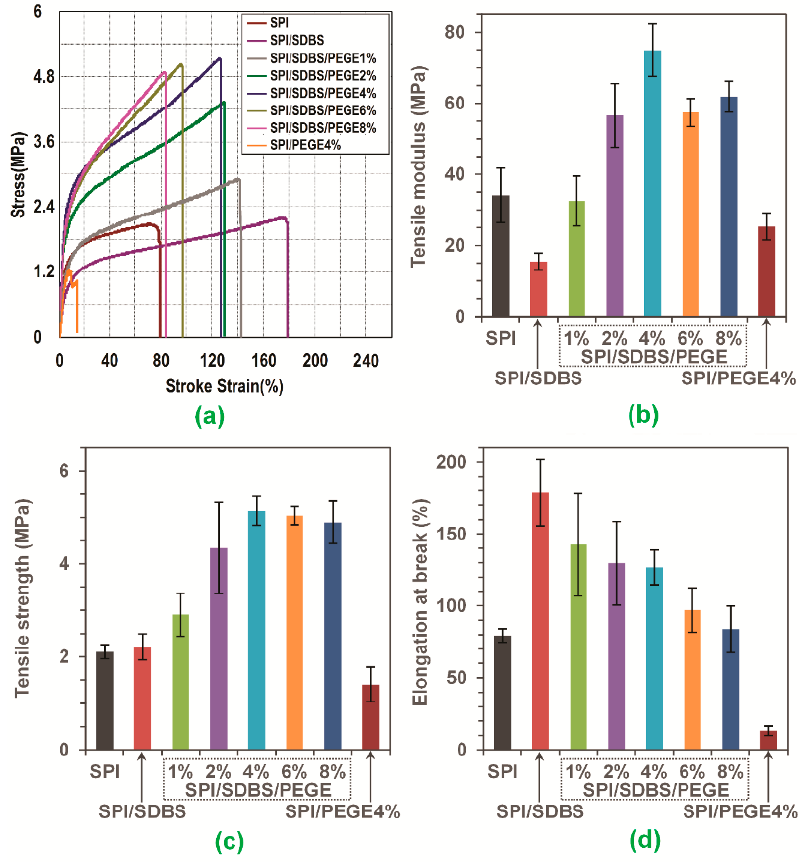
Figure 7. Tensile properties of the SPI-based films, including ( a ) average strain-stress curves, ( b ) tensile modulus (TE), ( c ) tensile strength (TS), and ( d ) elongation at break (EB). Table 4. A comparison of tensile modulus, strength and elongation at break of the SPI/SDBS/PEGE films by adding various amounts of PEGE.